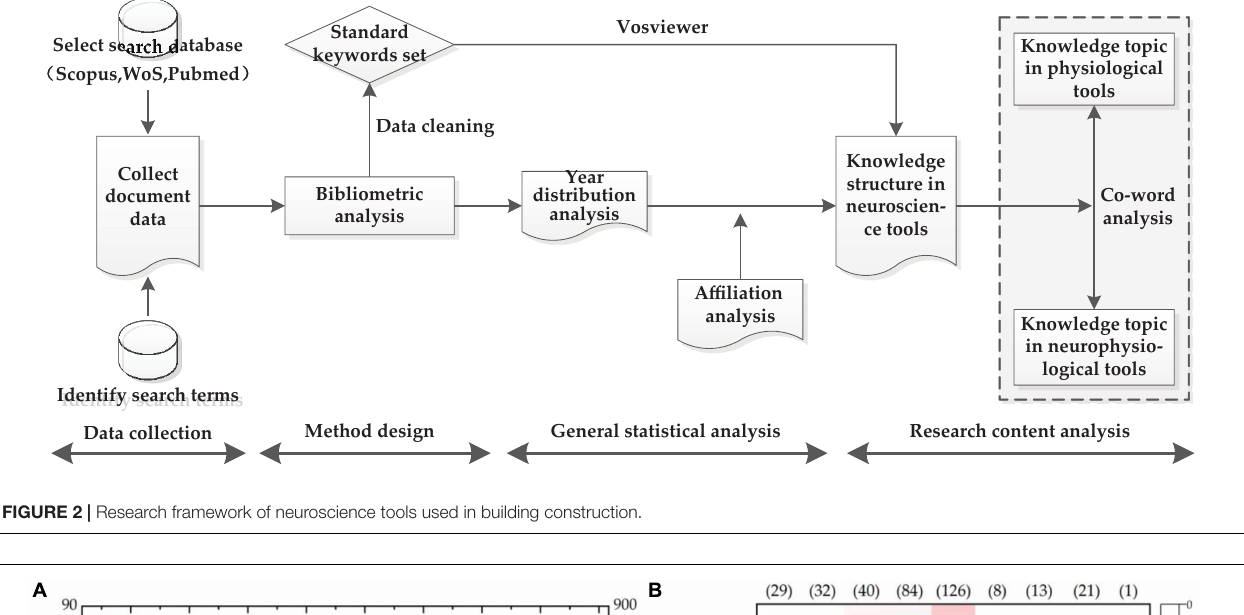
FIGURE 2 | Research framework of neuroscience tools used in building construction.